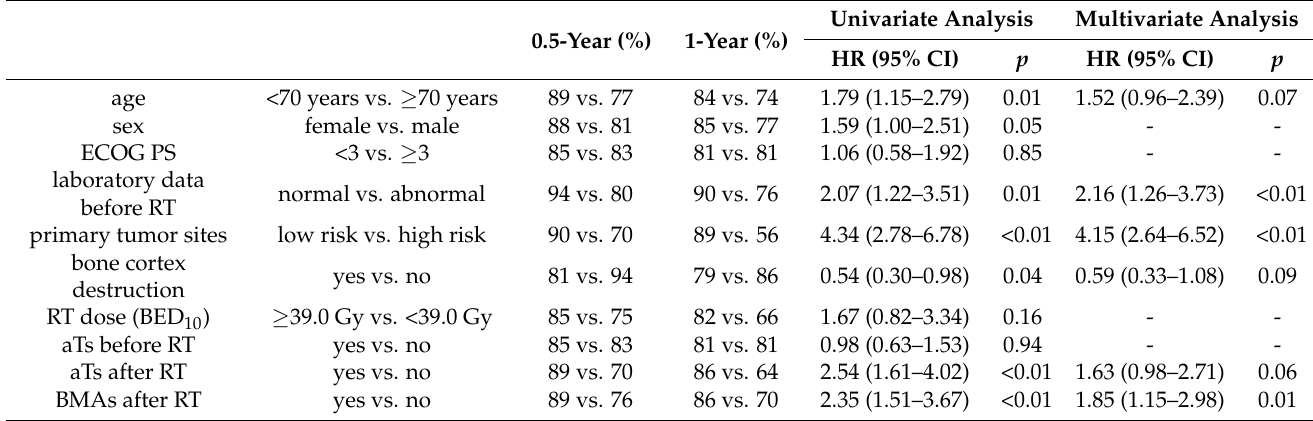
Table 3. Results of univariate and multivariate analyses for local control of RT